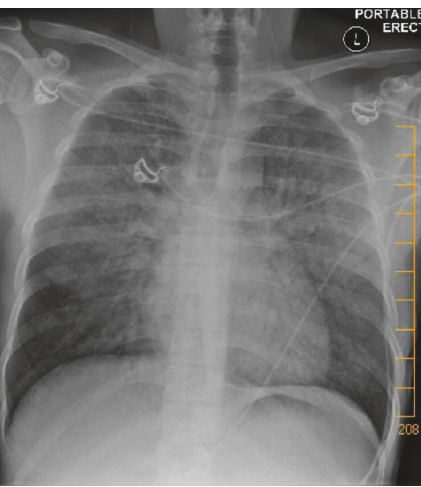
Figure 1: Anterior-posterior portable chest radiograph demonstrat- ing bilateral pulmonary opacities, consistent with